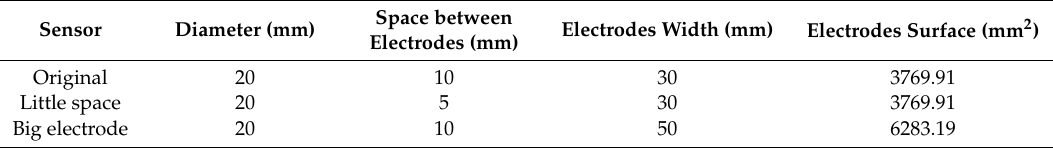
Table 1. New electrode dimensions.